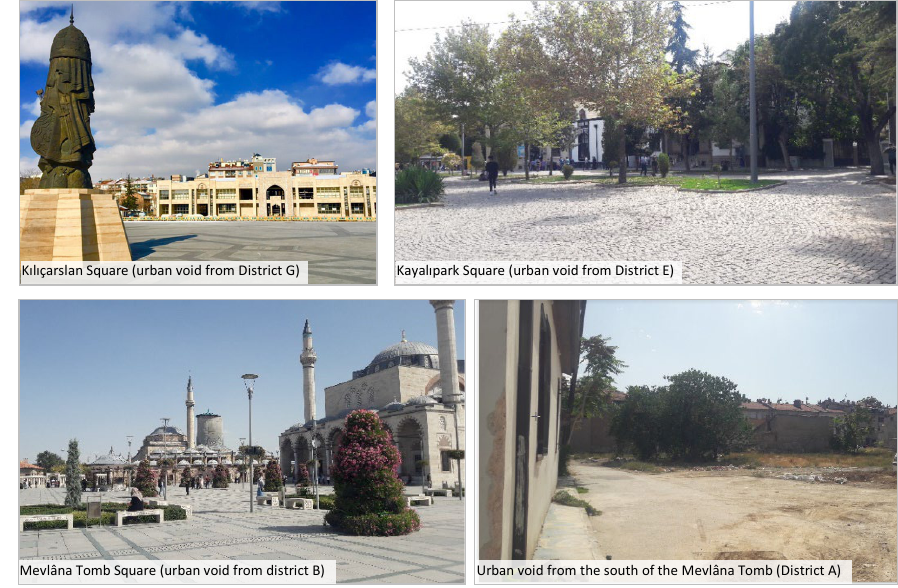
Figure 13 Photographs from the districts showing the functional structure of the urban voids (Ünal,